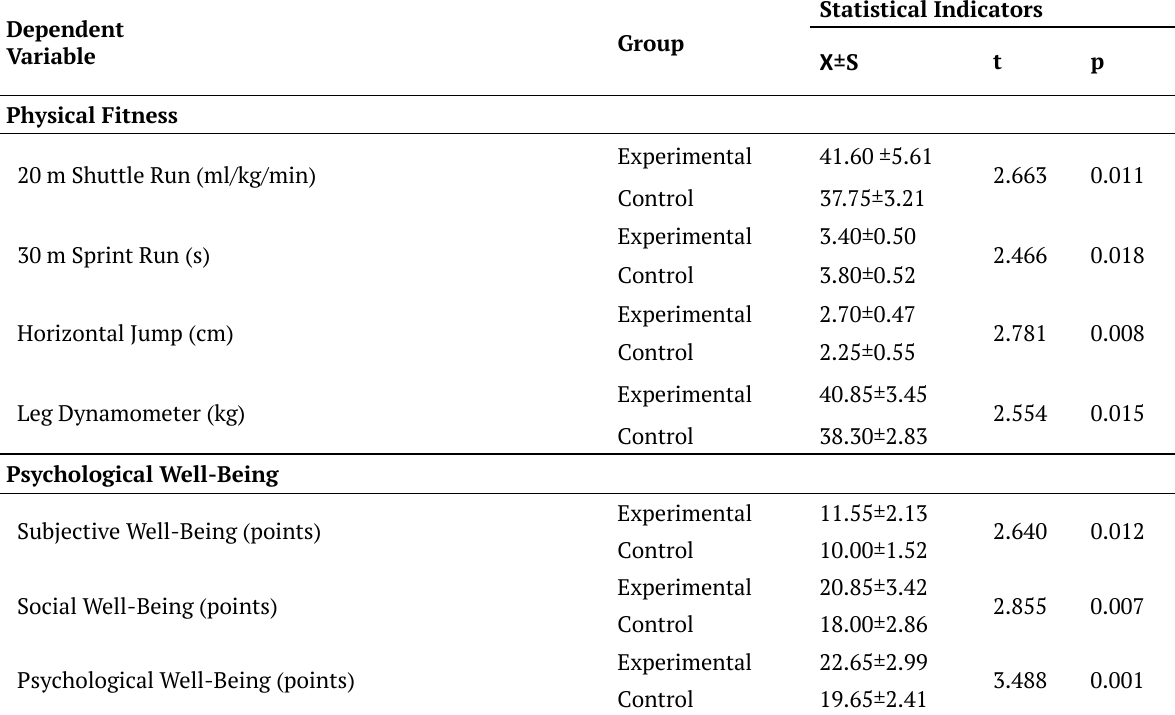
Table 5. The results of differences physical fitness and psychological well-being on the experimental (n=20) and control (n=20) groups after the